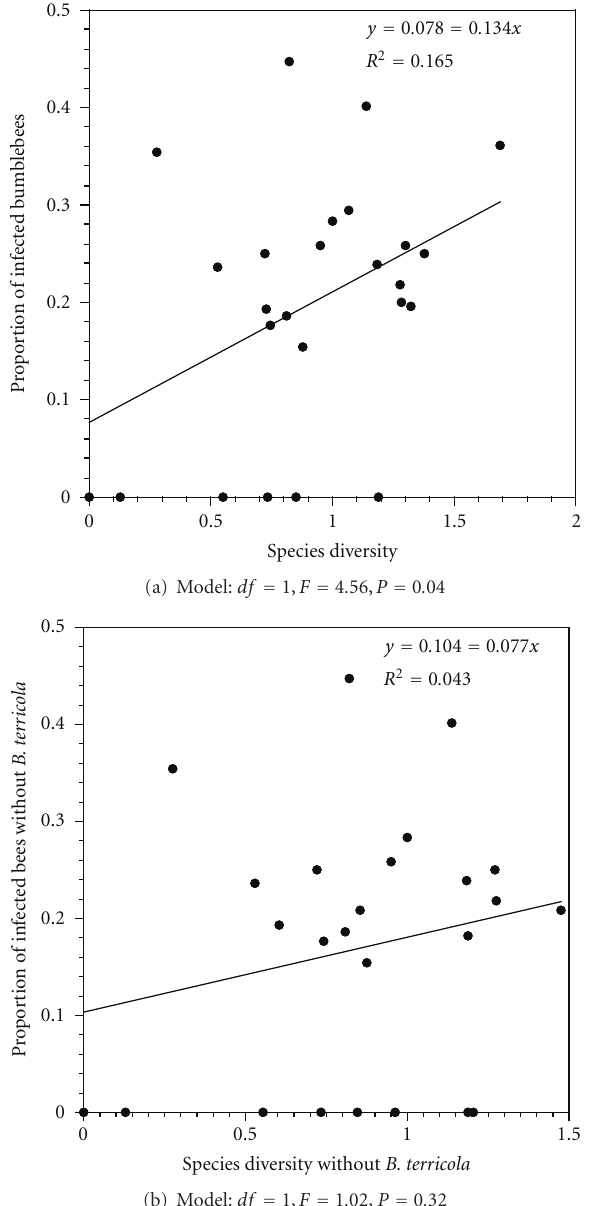
Figure 6: Nosema infection (square root proportion infected) of bumblebees relative to species diversity in 25 blueberry fields in 2009 and 2010 with and without B. terricola .